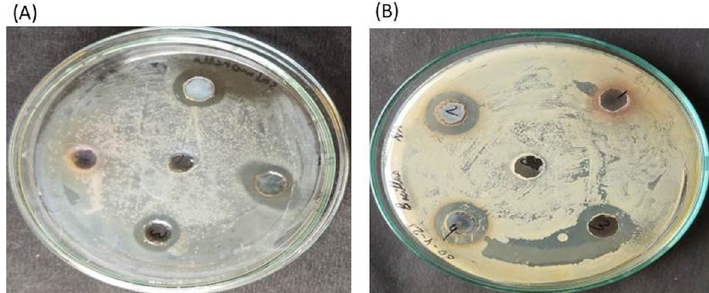
Fig. 8 The inhibition zone occurred by Polygonum plebeium leaf synthesized AgNPs in bacterial culture ( A ) Bacillus sp. ( B ) Salmonella